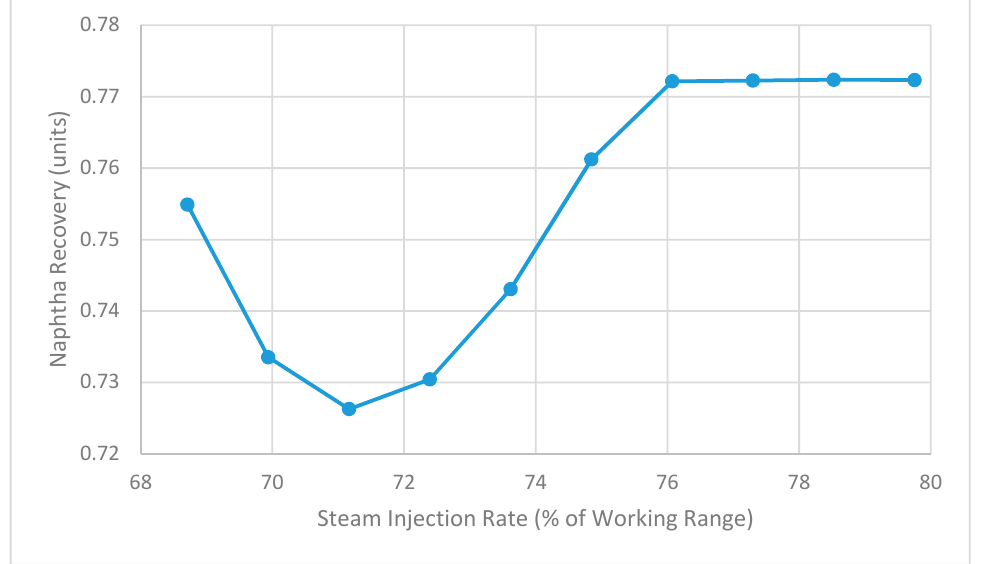
Figure 15. Impact of steam on naphtha recovery as predicted by Aspen Plus model.